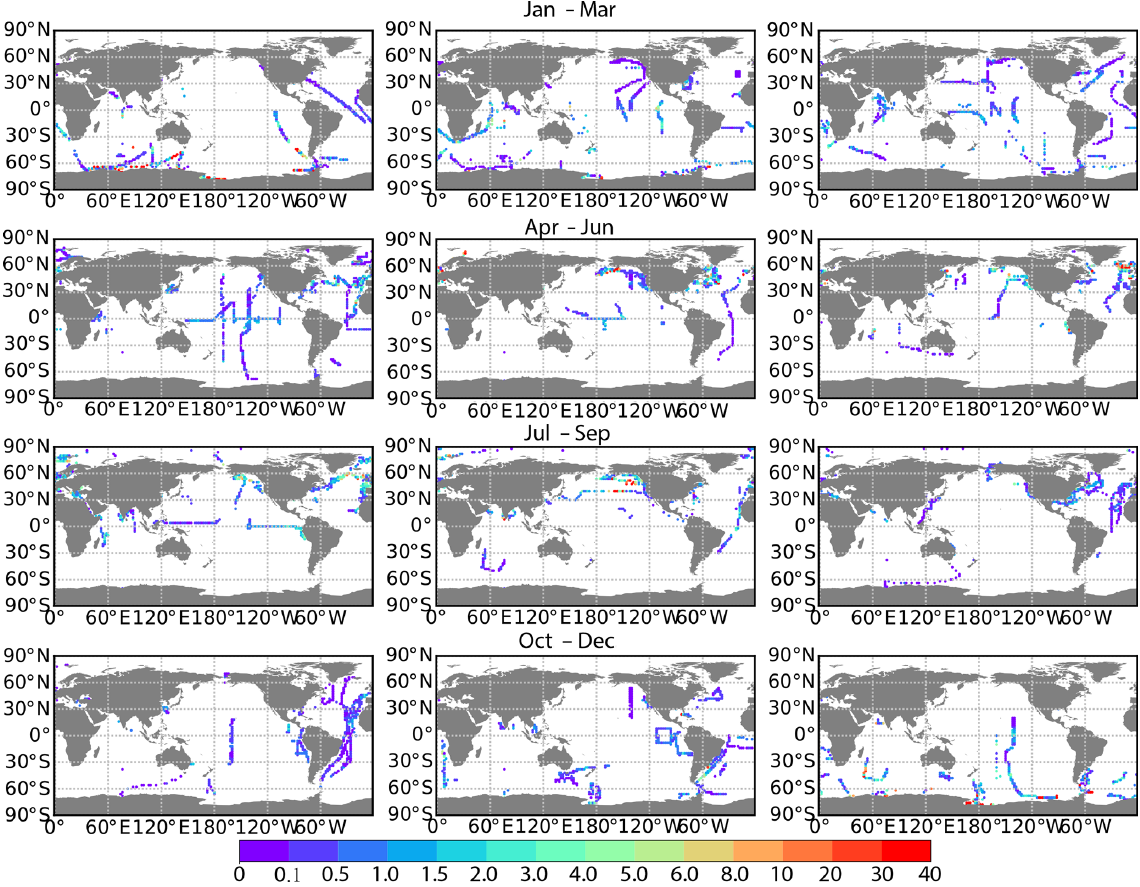
Figure A1. Distribution of DMS observations partitioned into each month. The color indicates DMS concentration